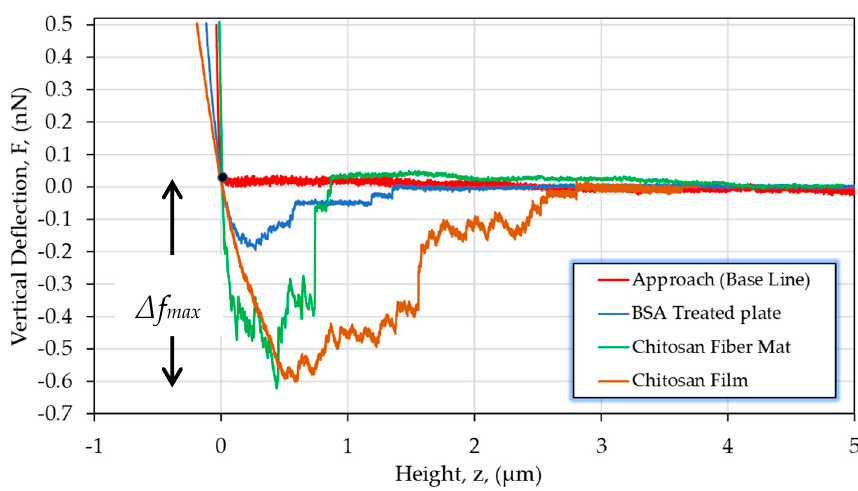
Figure 5. Comparative response for a chondrocyte detachment on chitosan substrates (film and fiber mat) and coated Petri dish. The point (0,0) on the curve F vs. z represents the cell-substrate contact point and ∆ f max the maximal normal force observed for the detachment response. Retraction velocity of 1 µ m/s and data shown for a contact time (t c ) = 60 s.